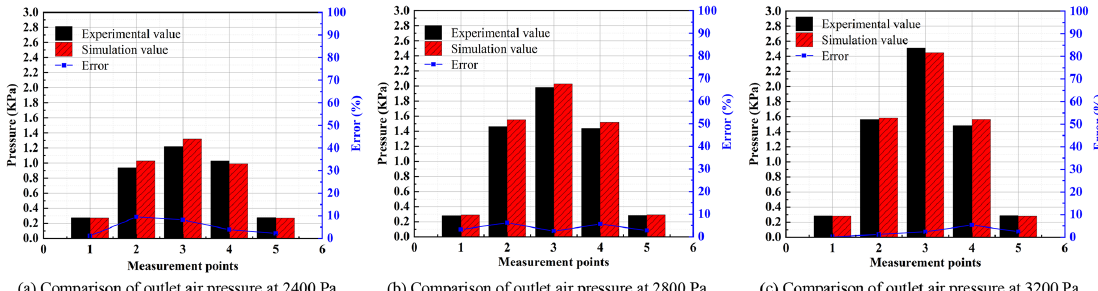
Figure 9. Simulation and test comparison of outlet air pressure at different negative pressures.